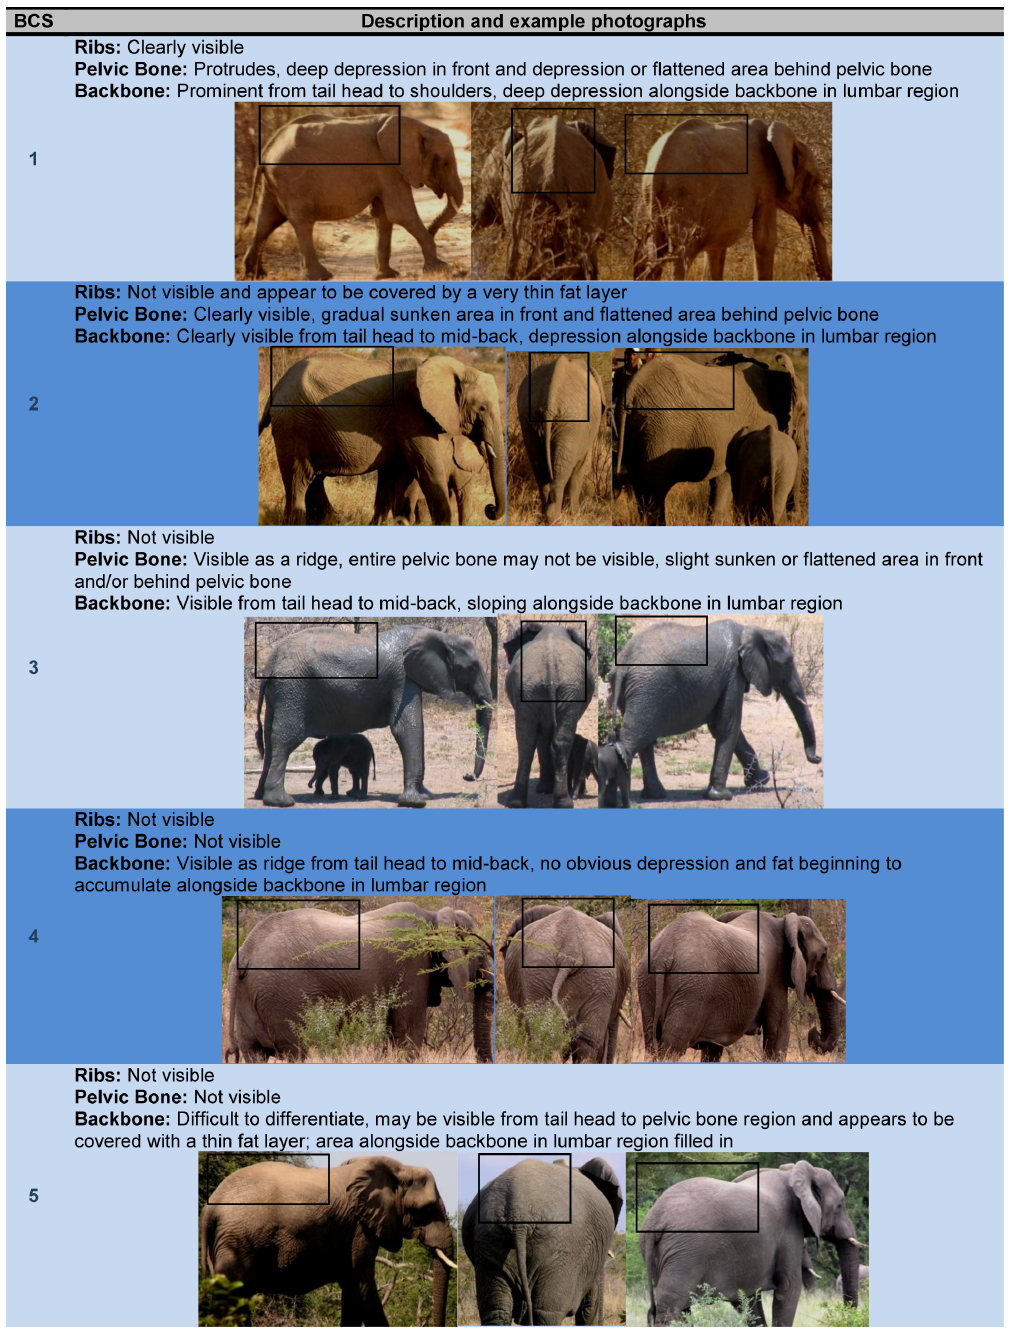
Figure 3. Body condition scoring index for female African elephants.